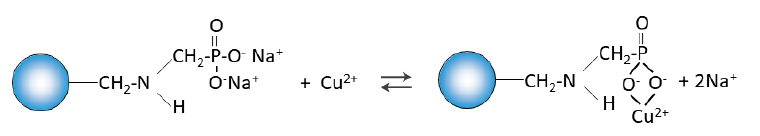
Figure 17. Possibility of ion exchange between Na(I) and Cu(II).